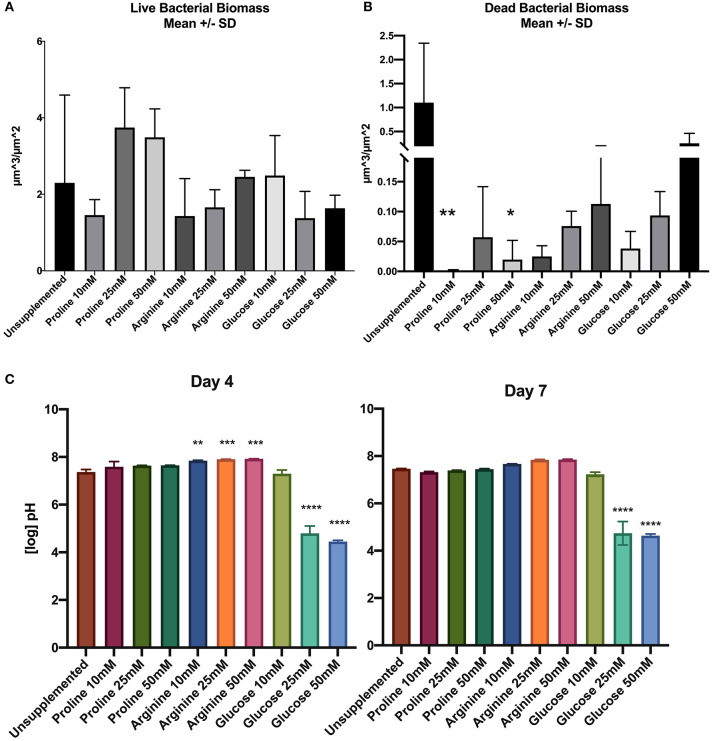
(A) Live bacterial biomass, (B) dead bacterial biomass, (C) pH of spent saliva growth medium. Units for biomass are μm3/μm2 (n = 3; *p < 0.05, **p < 0.005, ***p < 0.001, ****p < 0.0001).